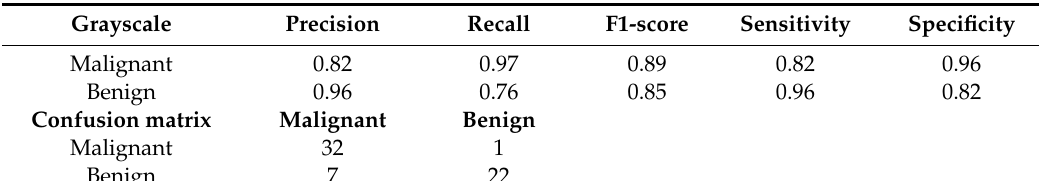
Table 10. Performance metrics and confusion matrix for grayscale images.